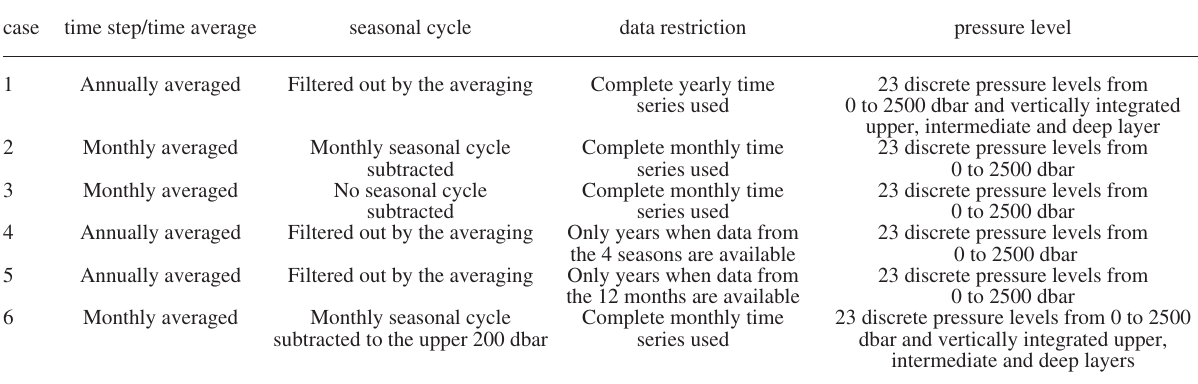
Table 2. – Definition of different data analysis methods (cases) and depth levels. The complete vertical profile is made of 23 pressure levels at 0, 10, 20, 30, 50, 100, 150, 200, 300, 400, 500, 600, 700, 800, 900, 1000, 1200, 1400, 1500, 1750, 2000, 2250 and 2500 dbar. in cases 1 and 6 upper, intermediate and deep layers are defined in different ways for different sub-cases (see the text in section